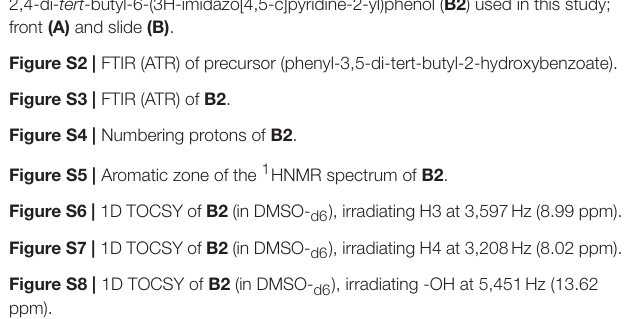
Figure S9 | UV-Vis spectrum of B2 in chloroform, acetonitrile and DMSO at room temperature. Figure S10 | Scan-rate study for B2 . Interphase: Pt|1.0 · 10 − 2 M B2 + 1.0 · 10 − 1 M TBAPF 6 in anhydrous CH 3 CN. Table S1 | Characteristic constants of phenyl-3,5-di-tert-butyl-2-hydroxybenzoate ∗ and B2 . Table S2 | UV-Vis absorption spectra of B2 in different organic solvents at room temperature. Table S3 | Scan-rate study for determining diffusional control of described electrochemical processes at B2 . Table S4 | Results for the geometry optimization of the ground (S0) and first excited singlet (S1) state. Table S5 | The most important absorption and emission bands for B2 in